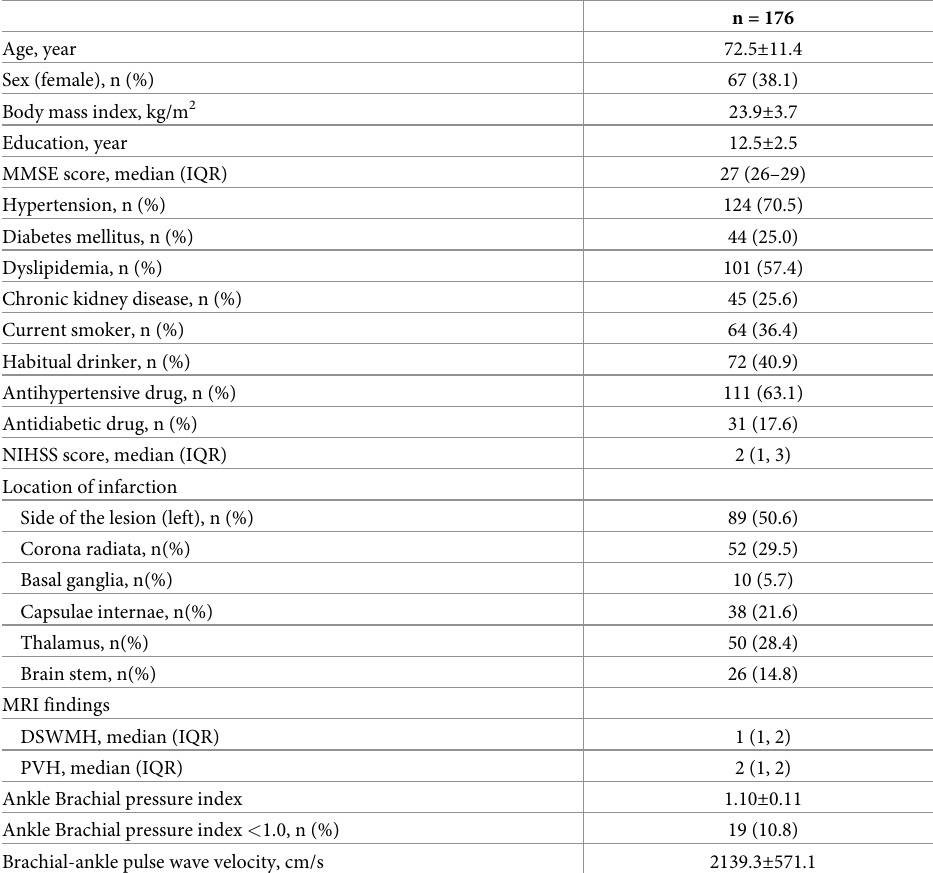
Table 1. Patients’